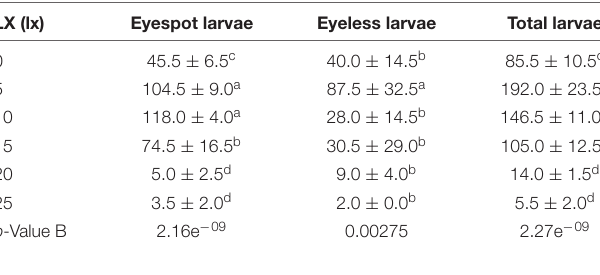
TABLE 7 | The density distribution of eyespot larvae, eyeless larvae, and total larvae of hybrid oysters under 0, 5, 10, 15, 20, and 25 lx light. LX (lx) Eyespot larvae Eyeless larvae Total